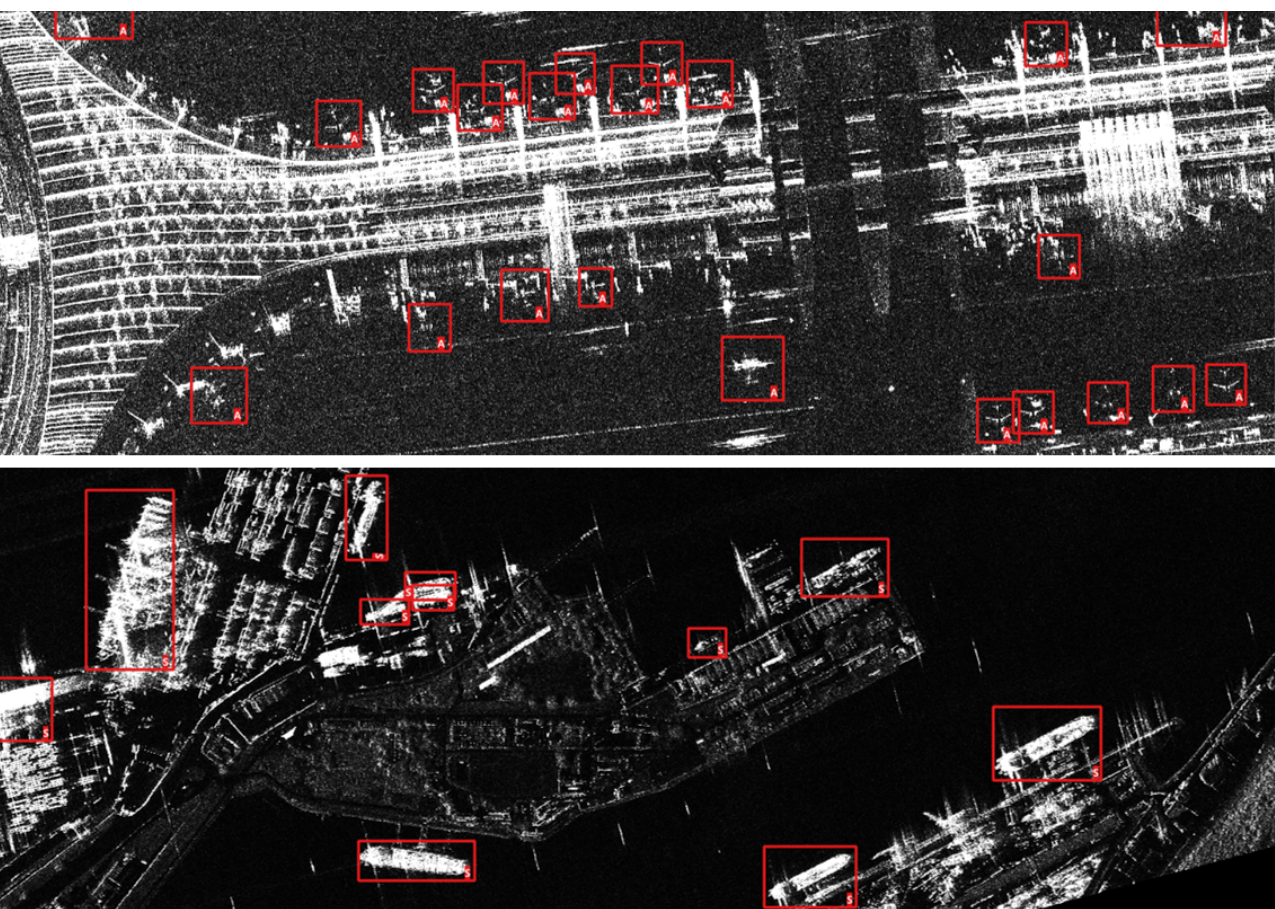
Figure 2. Example airplane (top) and ship (bottom) objects in TerraSAR-X image. The groundtruth bounding boxes labeled as corresponding class are plotted in red